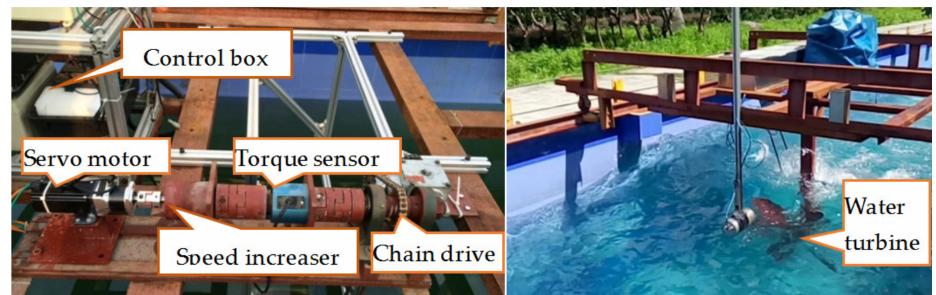
Figure 15. Physical image of the hydraulic turbine experimental device.